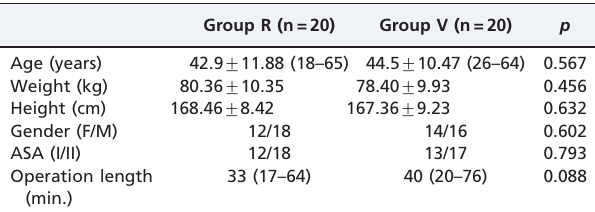
Table 2 - Demographic data (mean ¡